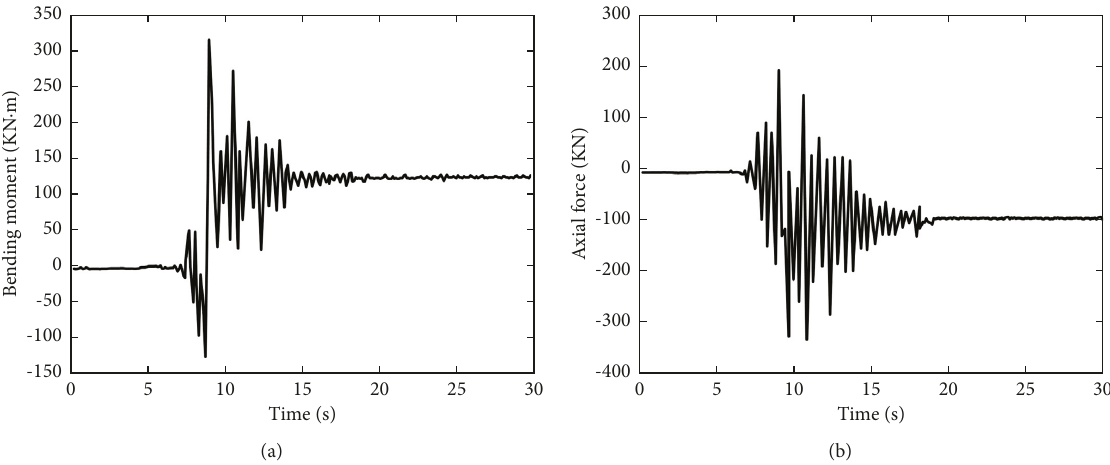
Figure 4: (a) Time history of bending moment of 45 ° position under seismic force. (b) Time history of axial force of lining of 45 ° position under seismic force.